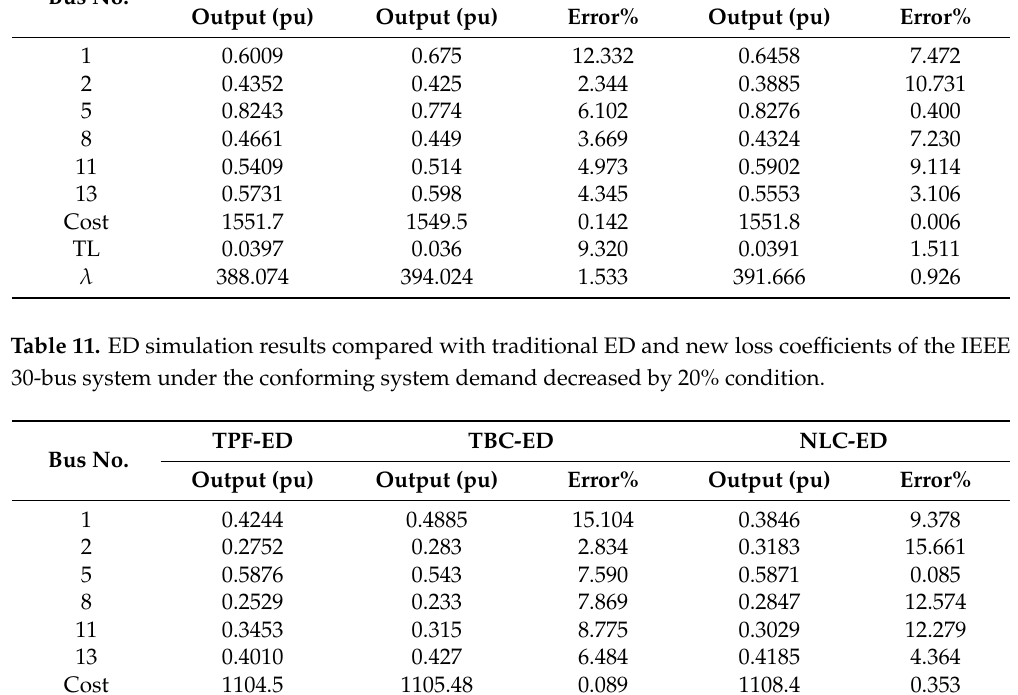
Table 10. ED simulation results compared with traditional ED and new loss coefficients of the IEEE 30-bus system under the conforming system demand increased by 20% condition.